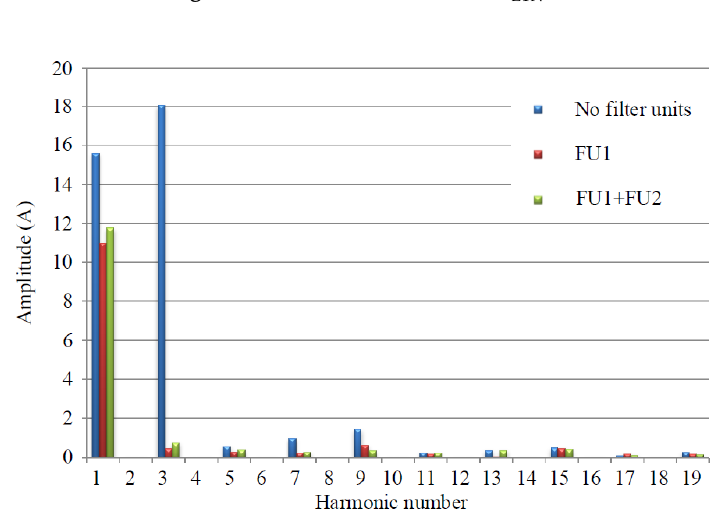
Figure 19. The current i L 1 N spectrum.